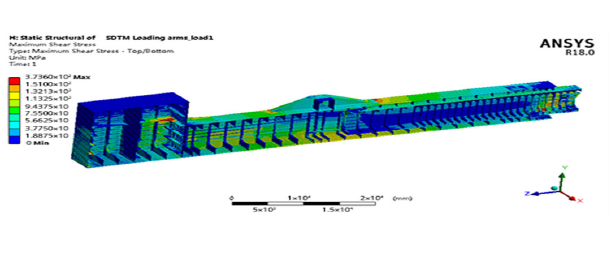
Figure 16. Static Stress Nephogram of the Lifting Arm.